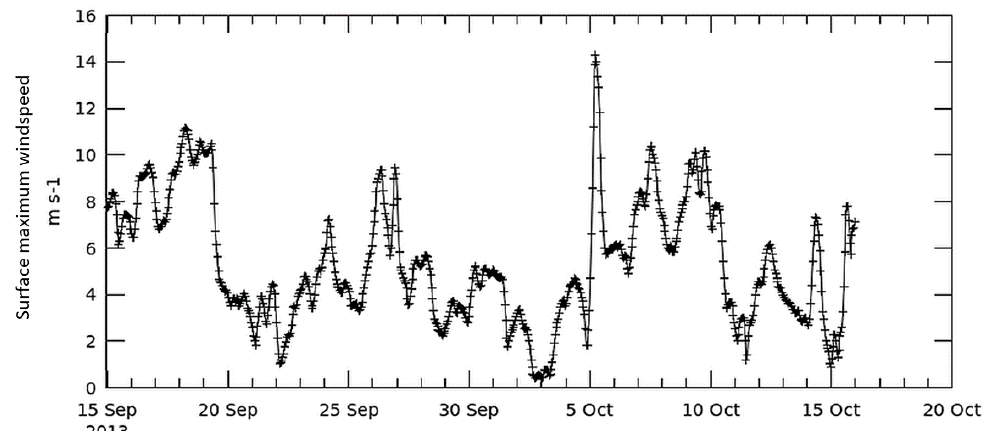
Figure 4. MERRA-2 surface maximum windspeed data for Chuuk Lagoon for the period 15 Septem- Figure 4.